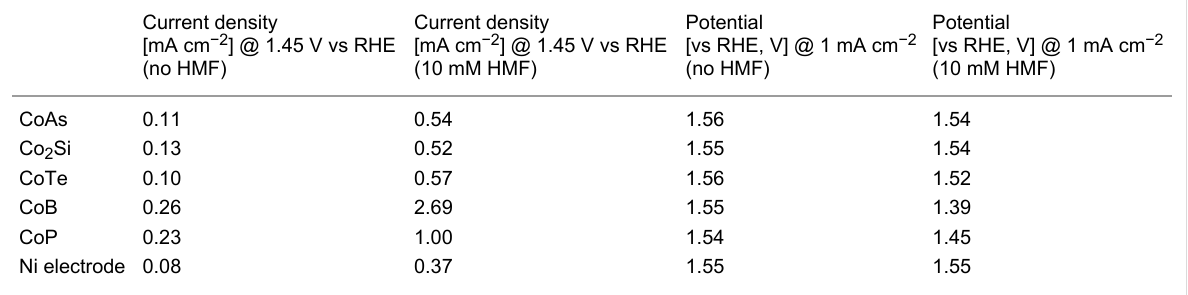
Table 1: A comparison of the OER and HMF oxidation activity of CoB, CoP, CoAs, Co 2 Si and CoTe modified Ni RDEs (data taken from LSVs of Figure 2).